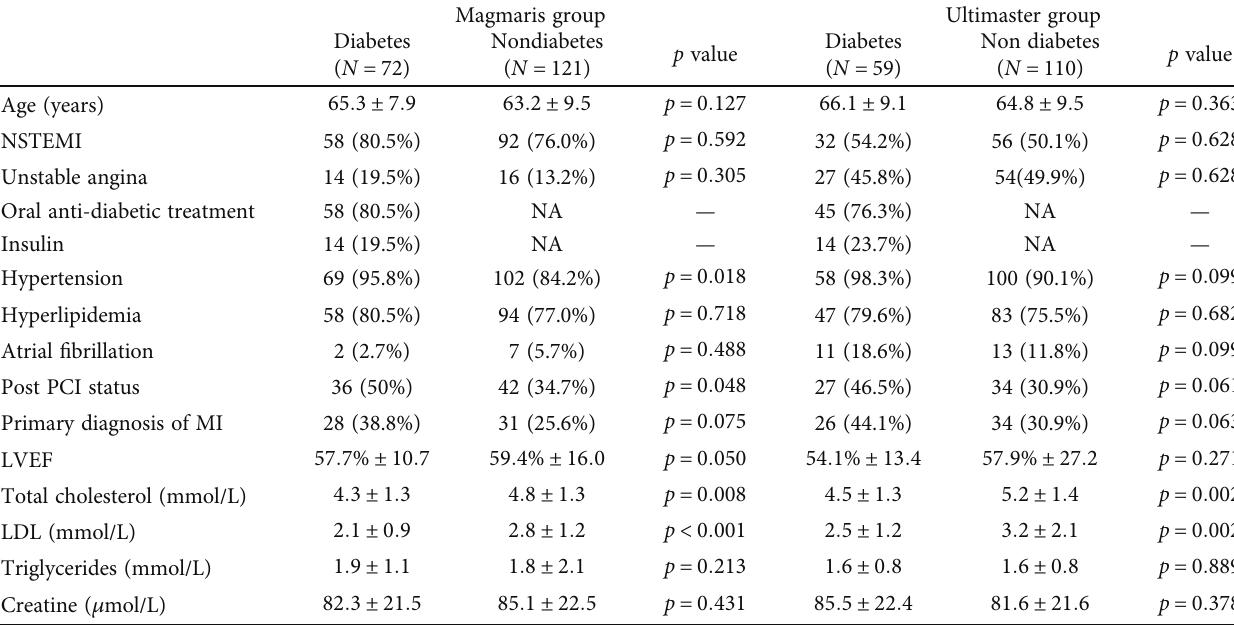
Table 1: Baseline clinical characteristics of both study